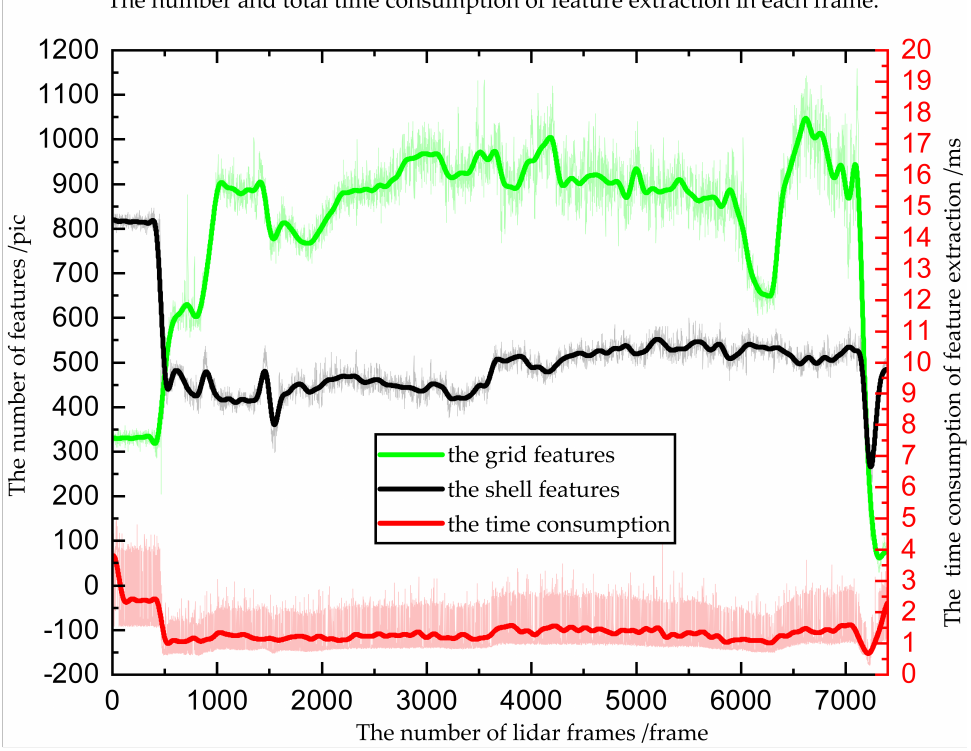
Figure 7. The number and time consumption of feature point